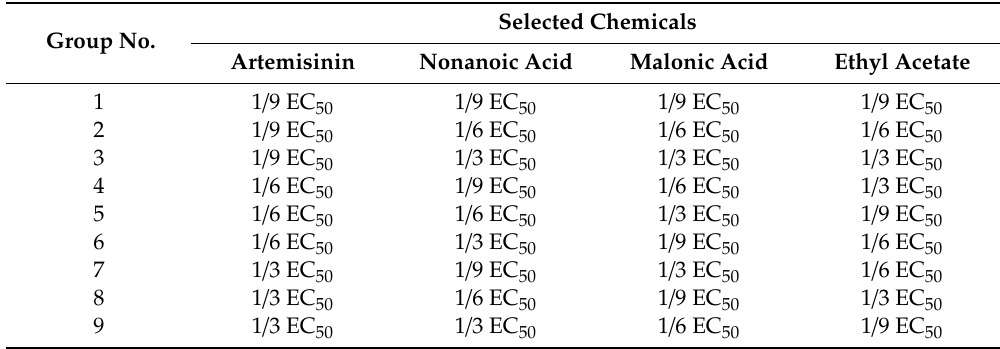
Table 1. Dosing proportions of the four selected allelochemicals in the L9 (3 4 ) orthogonal test. Selected Chemicals Group No. Artemisinin Nonanoic Acid Malonic Acid Ethyl Acetate 1 1 / 9 EC